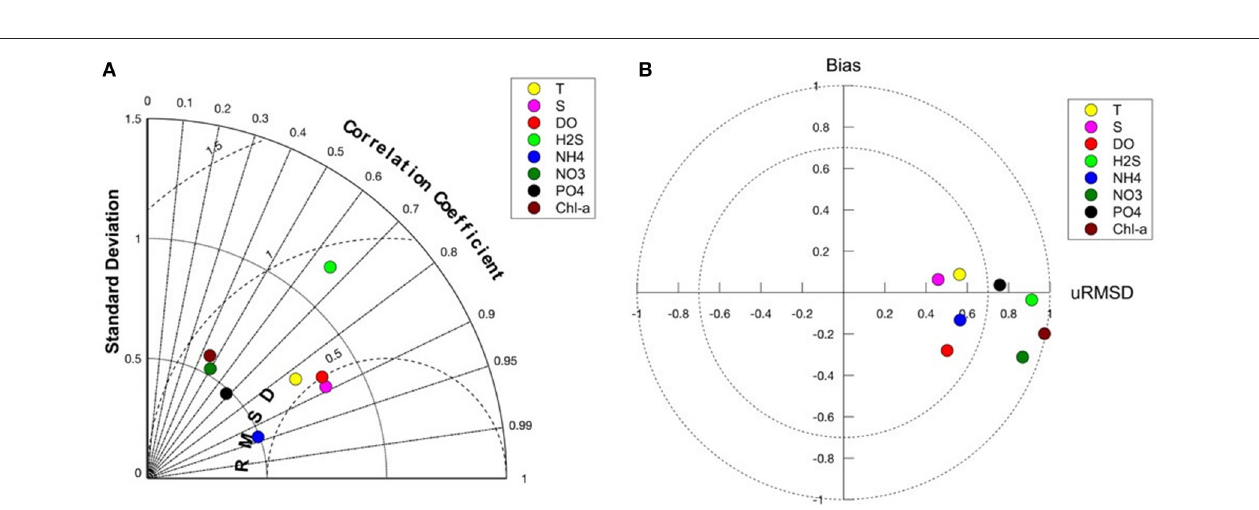
FIGURE 4 | Comparison of (A) model surface currents (cm/s) with (B) geostrophic currents (cm/s) computed from satellite derived absolute dynamic topography. In both plots, the currents were time averaged for 5 years (2010–2014).